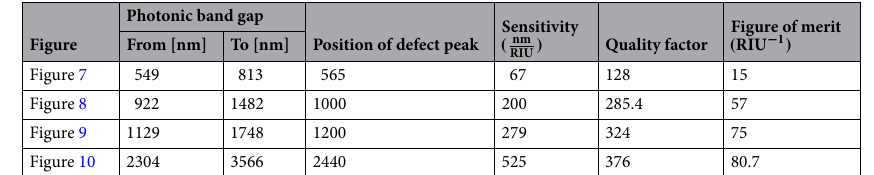
Position of defect peak